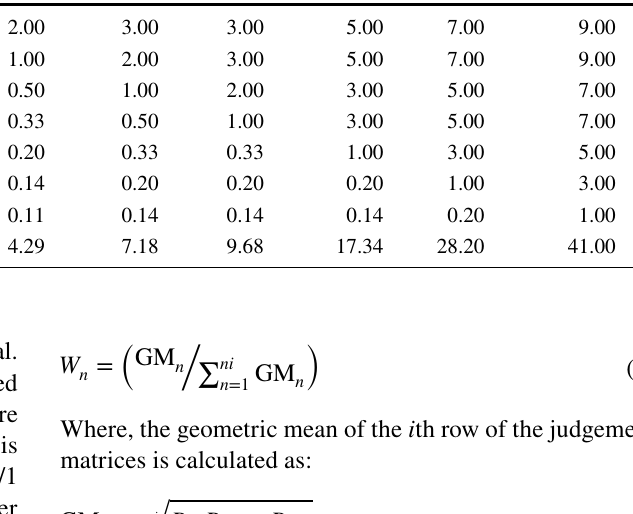
Table 3 Pairwise comparison of seven criterion decimal matrix